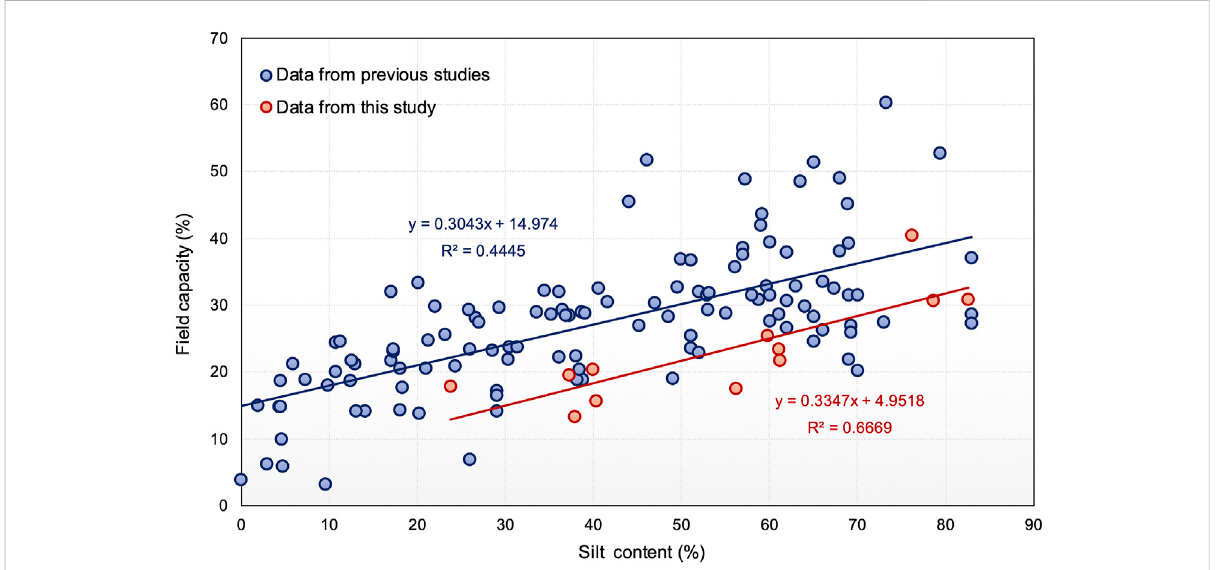
FIGURE 4 The signi fi cant linear correlation between fi eld capacity of soil and the proportion of silt in the soil. The dataset plotted in blue was collected from previous studies (Pabin et al., 1998; Liu et al., 2007, 2015; Khan et al., 2009; Harrison-Kirk et al., 2014; Peake et al., 2014; López-Vicente et al.,